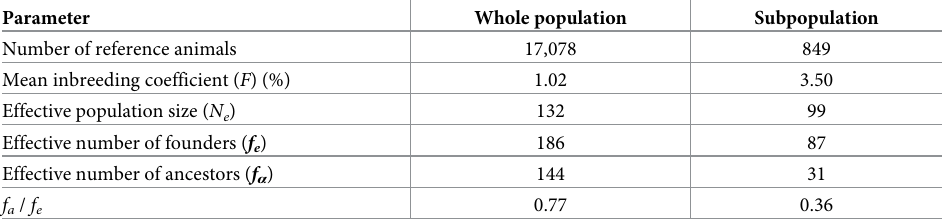
Table 3. Parameters describing inbreeding, effective size and the concentration of genes in the whole and subpop- ulations of the German White-headed Mutton sheep pedigree. Parameter